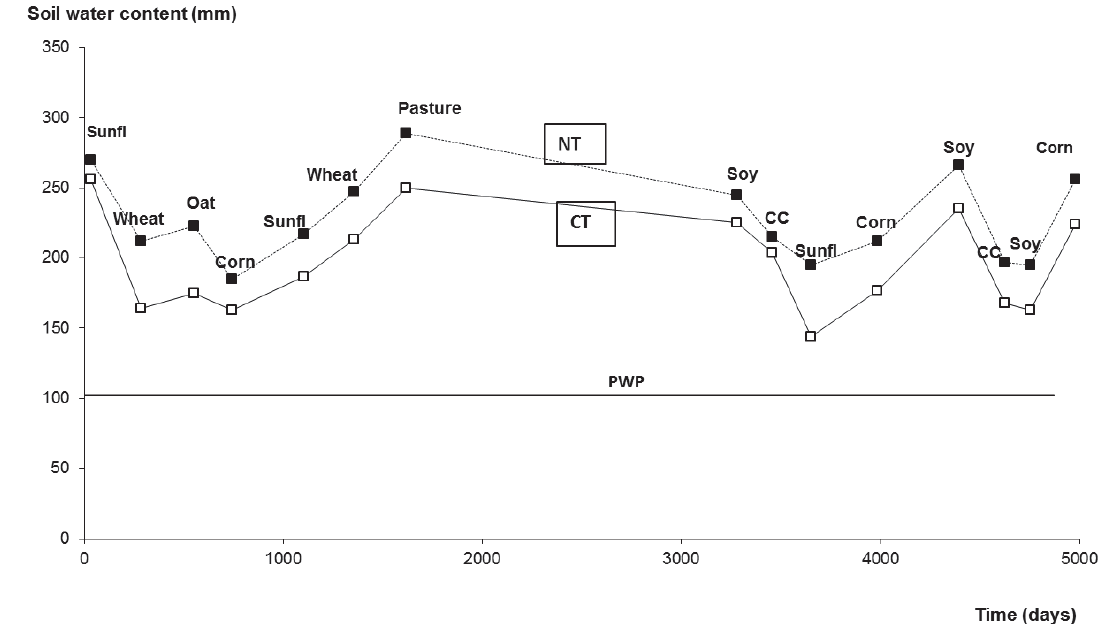
Figure 2. Gravimetric available water contents (mm) in no-till (NT) and conventional tillage (CT) at seeding of each crop of the rotation. (PWP, permanent wilting